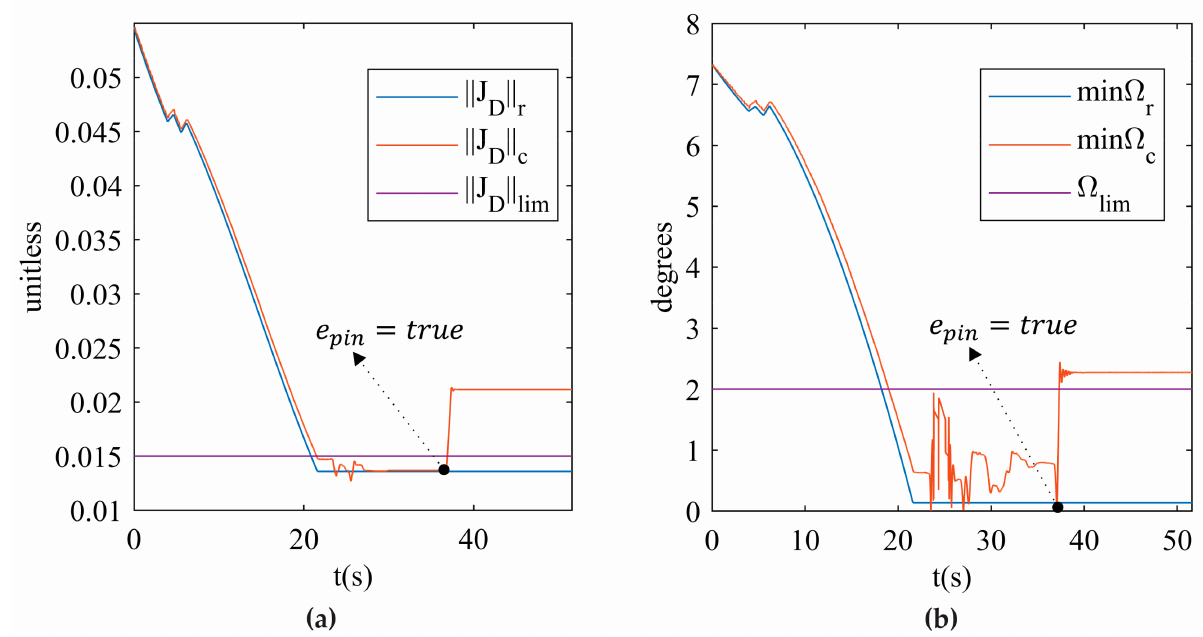
Figure 11. ( a ) (cid:107) J D (cid:107) ( b ) min Ω for trajectory 1 in the